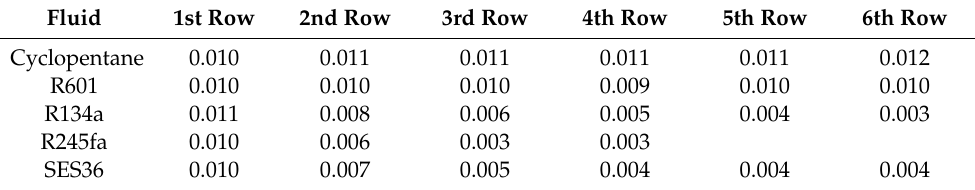
Table 9. Axial blade length (expressed in (m)) at the inlet of each row for di ff erent working fluids.